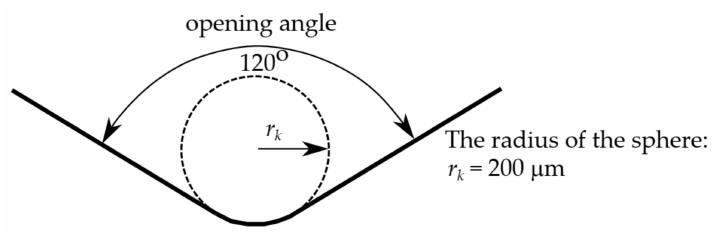
Figure 4. Cross-section of the tip of the sphero-conical diamond indenter.